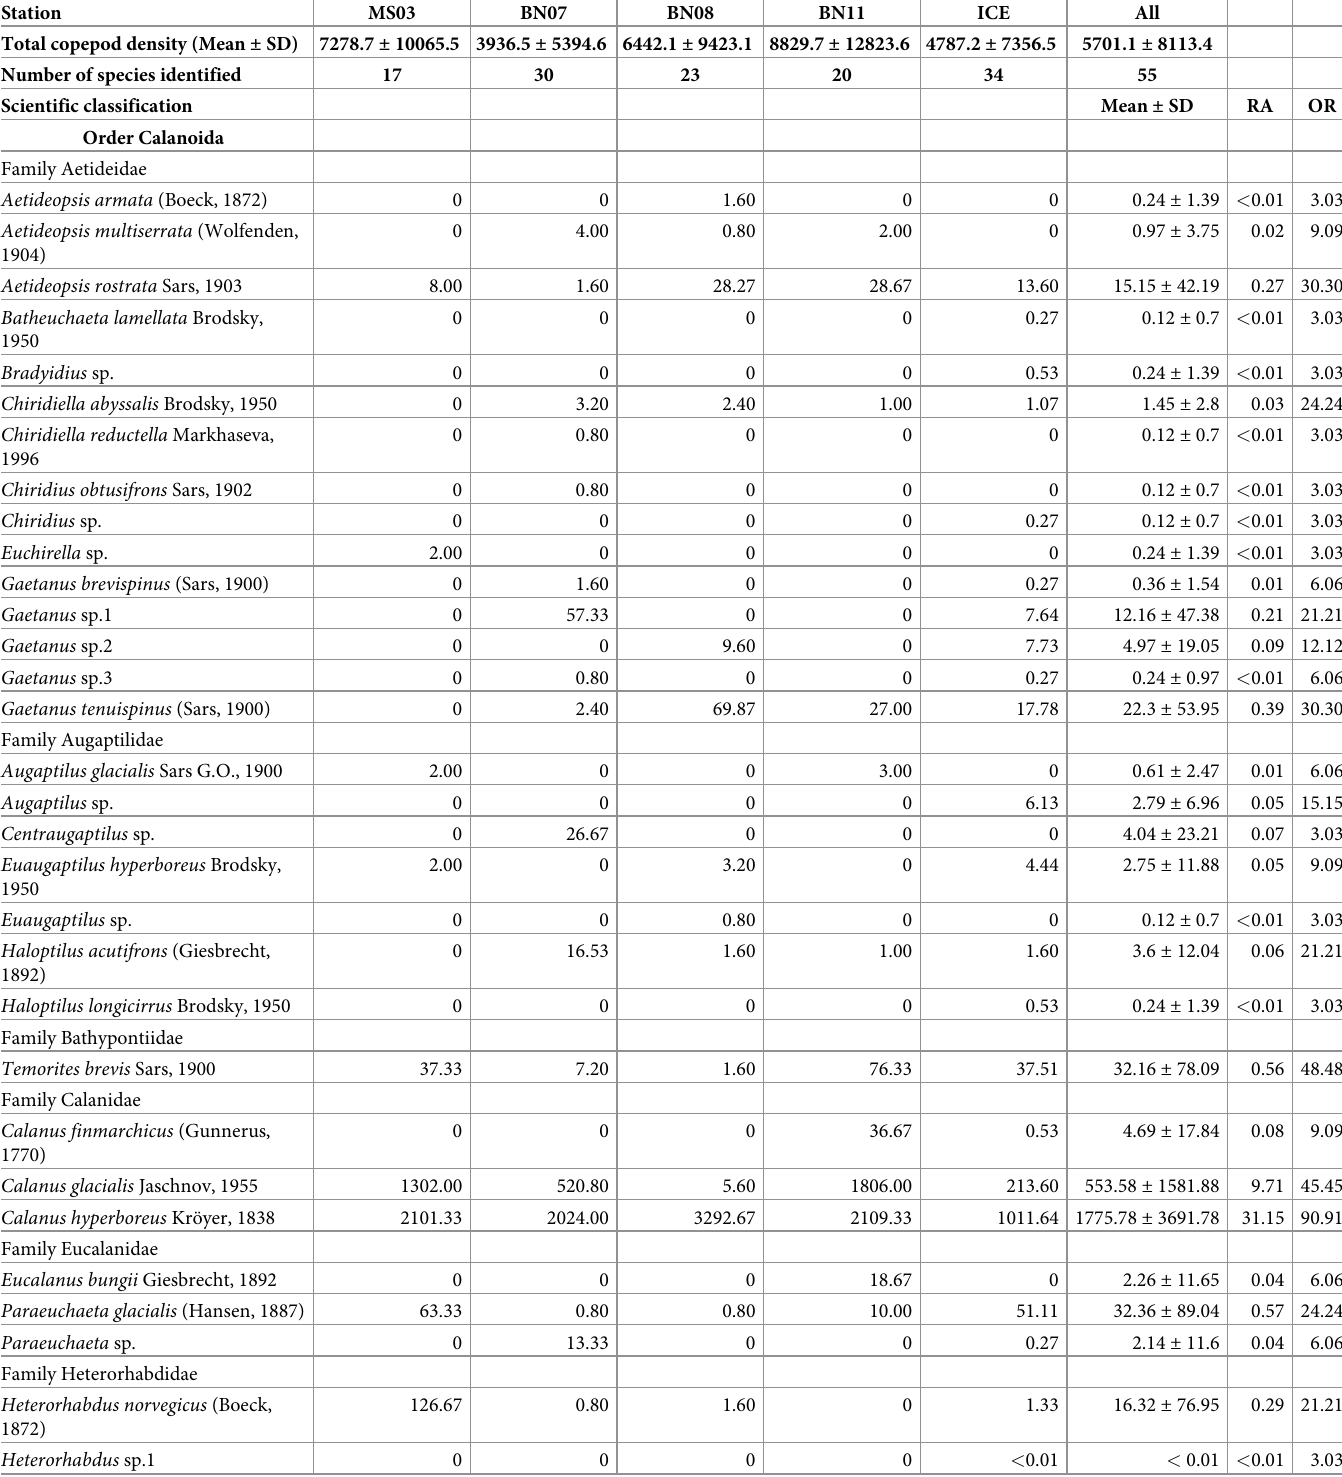
Table 2. List of plankton copepods (adult and copepodite) collected in the Arctic Sea in 2010, with their mean absolute abundance, relative abundance (RA, %), and occurrence ratio (OR, %) recorded from all samples.